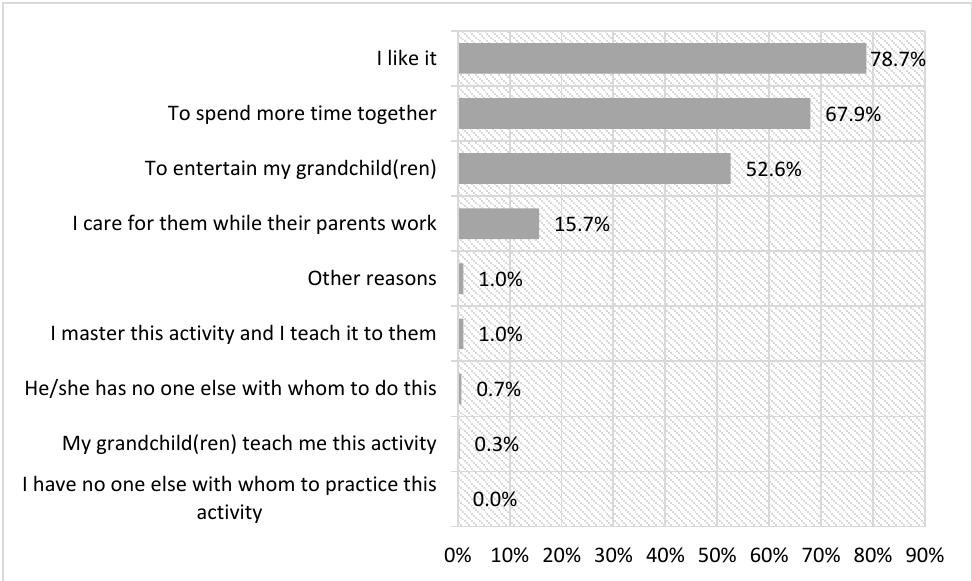
Figure 8. Reasons that guide the joint practice of festive leisure.